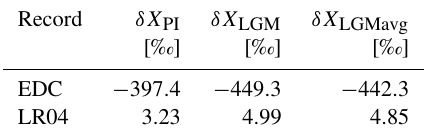
Table 4. Different isotope values adopted for the GI rescaling pro- cedure. LGMavg is the reference value obtained from the average between 26 and 19.5ka (which replaces LGM in Eq. 3 for the re- spective experiments; see Sect.